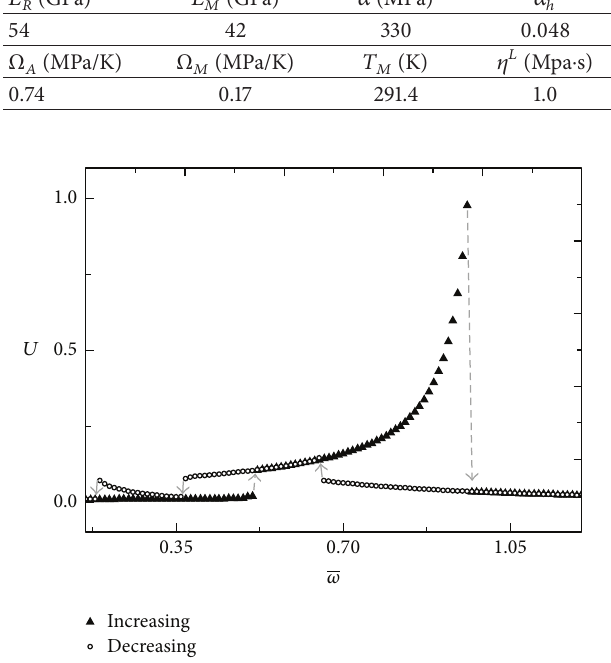
Figure 8: Maximum system amplitude with 𝛿 = 0.012 and increasing the forcing